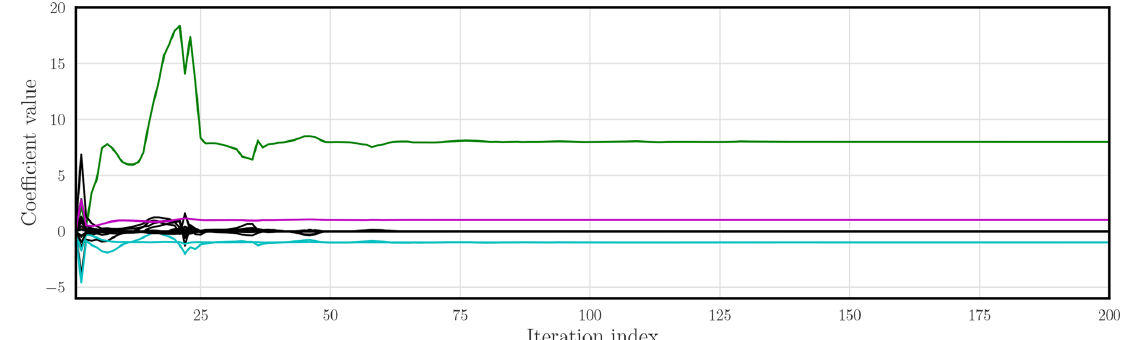
Figure 9. L96 is the reference model, which is fully observed without noise: plot of the N a = 18 coefficients of the surrogate model as a function of the minimisation iteration number. The coefficient of the forcing ( F ) is in green, the coefficients of the convective terms are in cyan, and the dampening coefficient is in magenta.